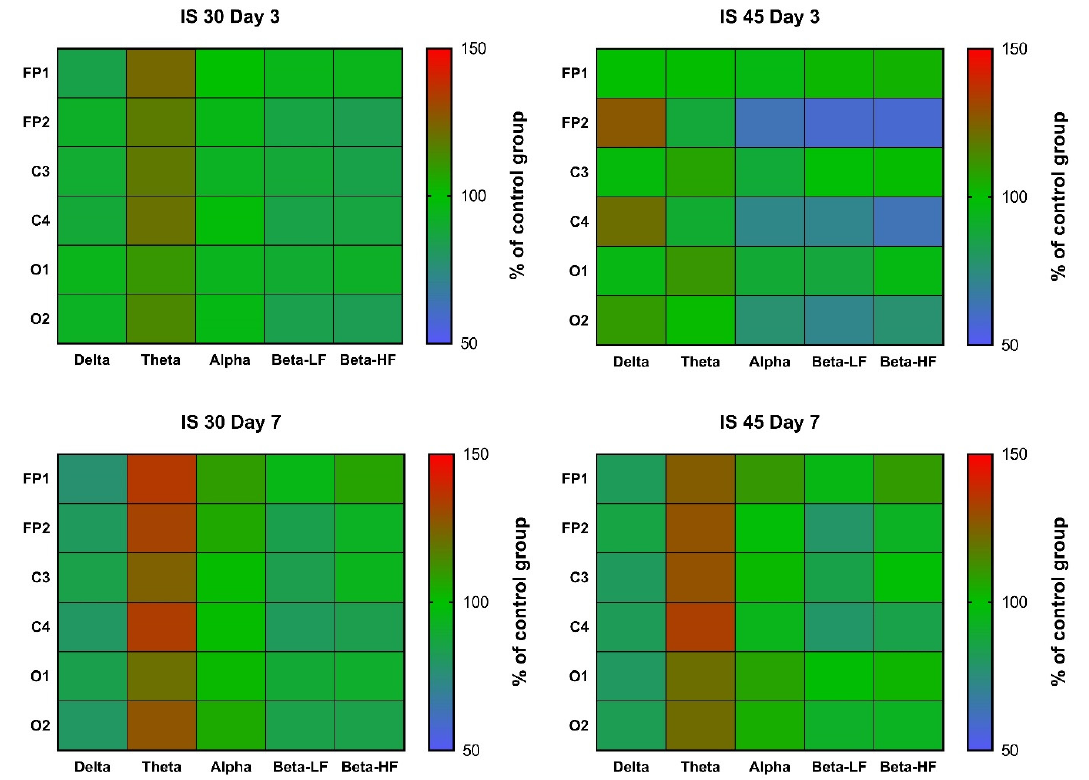
Figure 4. Heatmaps of δ , θ , α , high and low frequency β wave rhythm indices in channels FP1, FP2, C3, C4, O1, and O2 at post-surgery days 3 and 7. Data were normalized to the respective control values ( n = 6). IS 30 ( n = 6) and IS 45 ( n = 6), groups subjected to cerebral ischemia for 30 and 45 min, respectively.